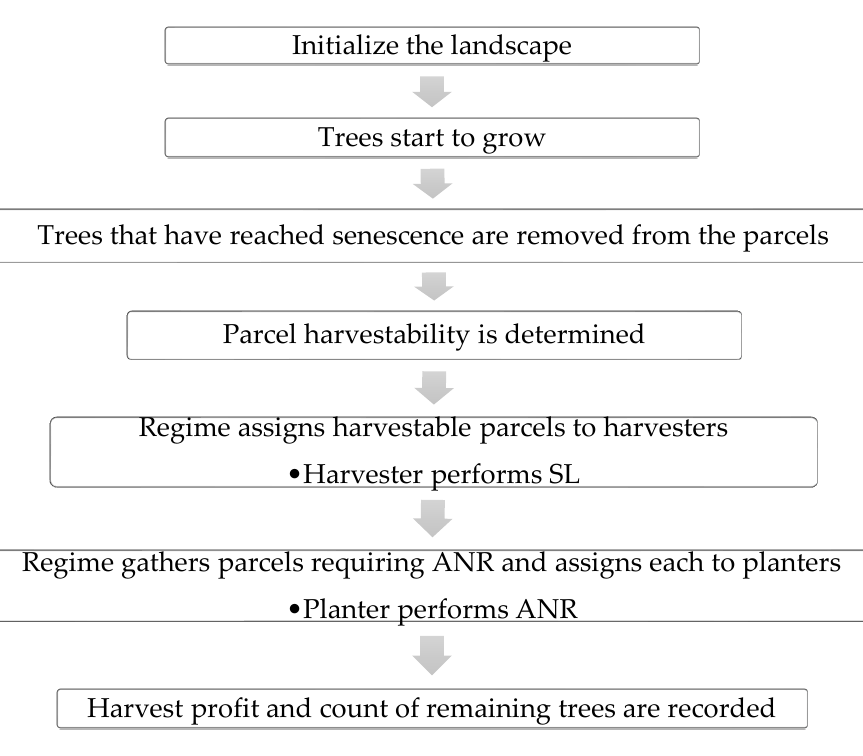
Figure 1. Scheduling of the successive steps in a year simulated by the GAMA Forest Model